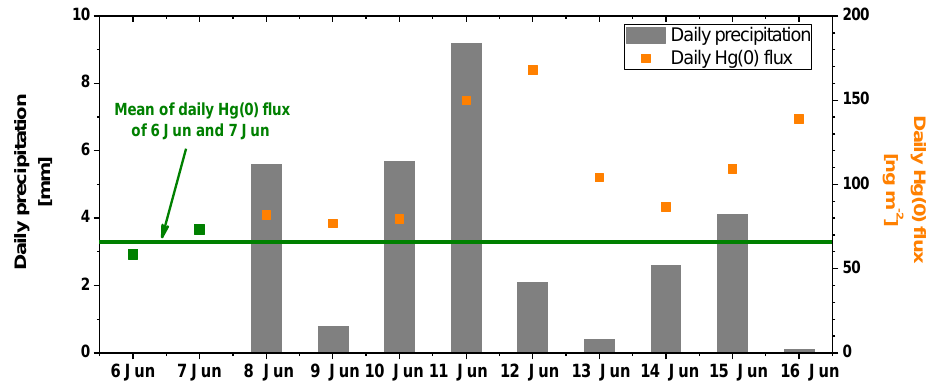
Figure 6. Daily Hg(0) flux and daily precipitation in the June 2014